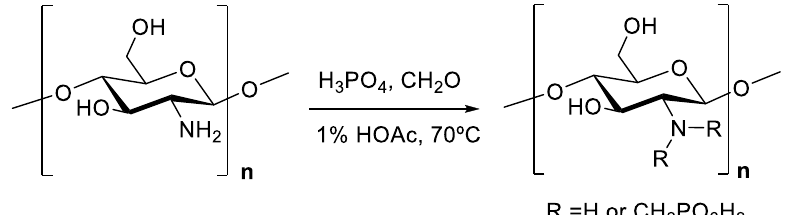
Figure 2. Scheme of phosphorylated chitosan derivative synthesis.